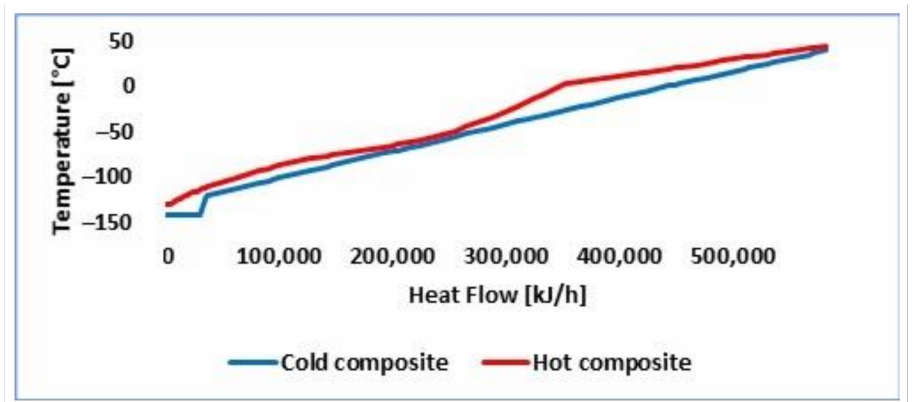
Figure 13. Heat transfer composite curves for VS